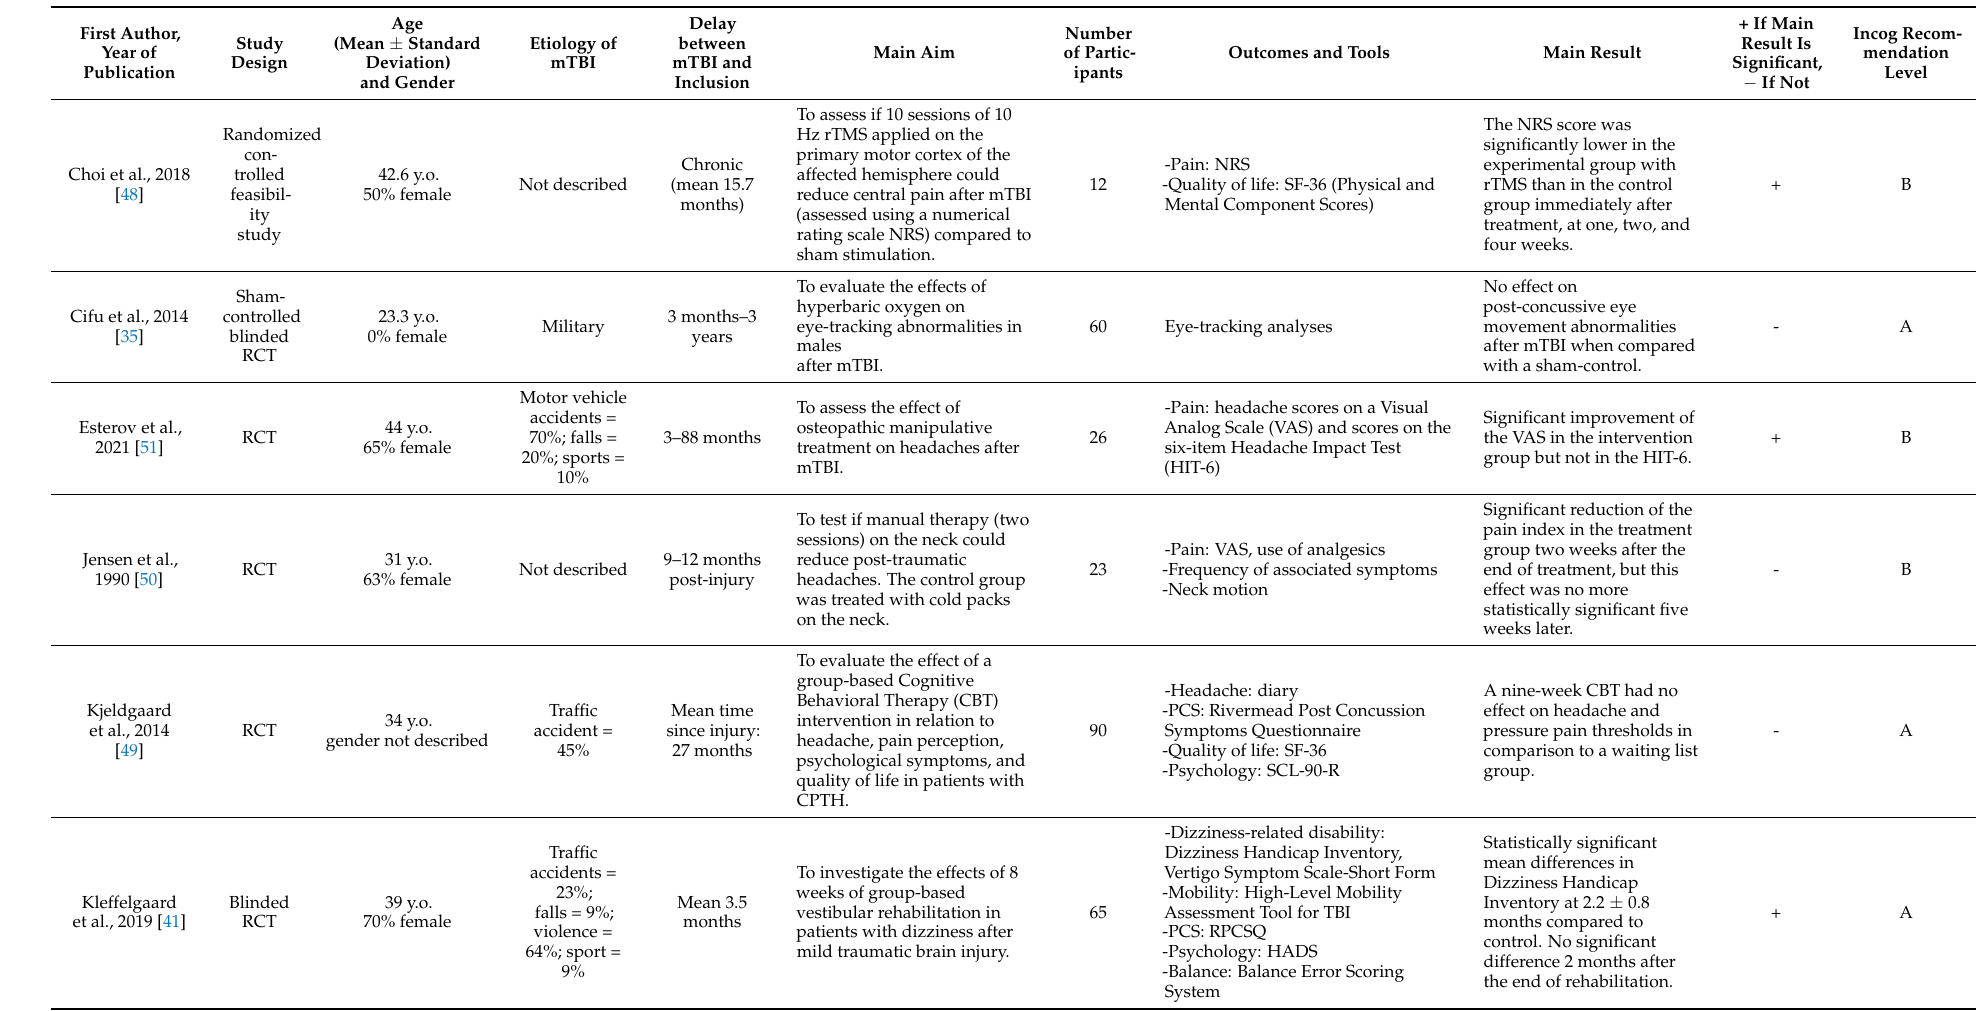
Table A3. Treatment of somatic complaints and fatigue (15